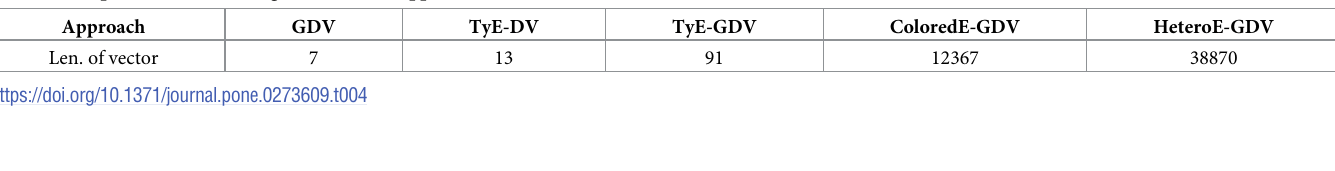
mean metric score given the stochastic nature of decision tree-based models. Table 3 lists the prediction results for six models. As this is a multi-class classification task, and the distribution of the four classes is imbalanced, the macro-F1 score is selected as the evaluation metric. A naive classifier named Stratified is also added to the table (the first row), which simply generates predictions by adhering to the class distribution in the training set. We see clearly that the bottom three approaches that encode type information in graphlets (raw features plus ColoredE-GDV, raw features plus HeteroE-GDV N , and raw features plus TyE-GDV) perform better than the set of raw features plus TyE-DV and the set of raw features plus GDV. Recall that TyE-DV captures edge type information but with very limited structural information, and GDV, on the other hand, captures the rich structural information but with- out edge type information. This evidently shows that combining edge type information and rich structural information could lead to more distinctive features in network learning tasks. We also observe large differences in the running time of those methods. The running time of the set of raw features plus ColoredE-GDV, and especially the set of raw features plus Het- eroE-GDV N are many times higher than other methods. This is because our dataset has 13 types of edges and the lengths of vectors generated from these two methods grow near expo- nentially with the number of edge types j T j . Correspondingly, the speed of the machine learn- e ing algorithm will slow down as the feature vector becomes larger. Table 4 gives the vector lengths of all five approaches. Note that there is no edge type information between alter nodes in many egocentric networks, including this case study dataset. Thus, our implementations of ColoredE-GDV and HeteroE-GDV N have excluded all the impossible combinations. Overall speaking, the proposed TyE-GDV is able to achieve acompetitive performance while maintain-